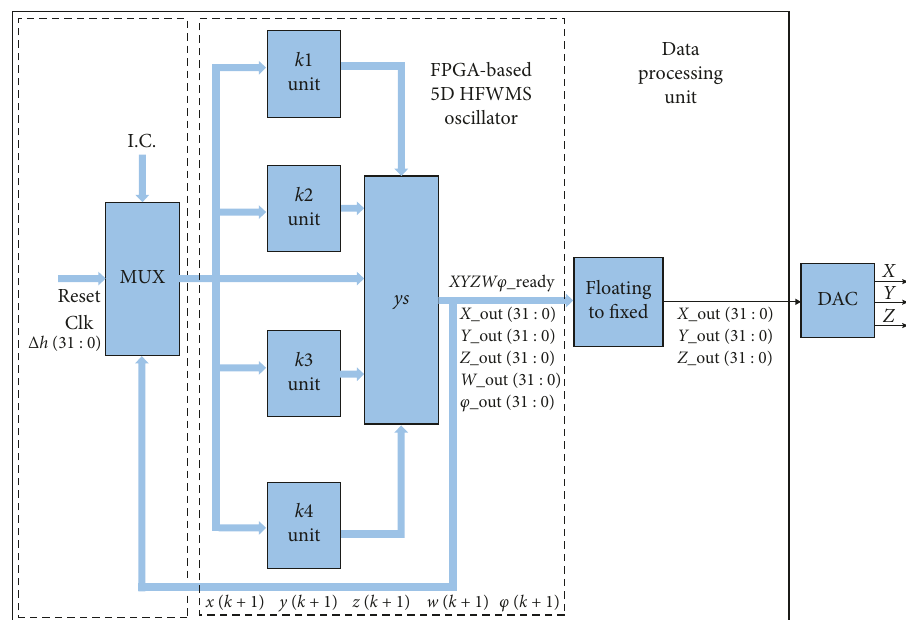
Figure 12: The third-level block diagram of the FPGA-based 5D HFWMS.